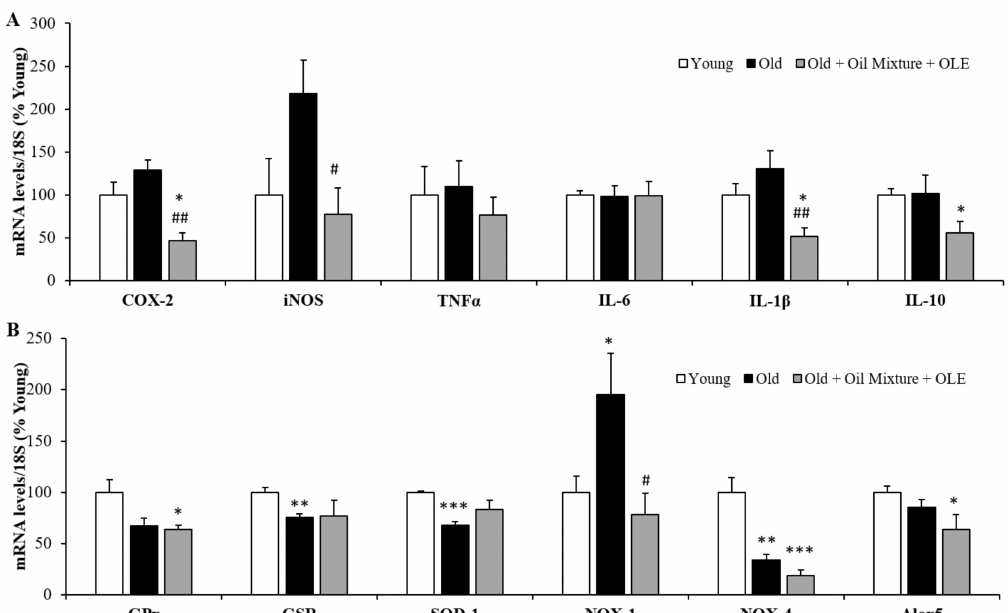
Figure 9. Cardiac mRNA concentrations of cyclooxigenase-2, inducible Nitric Oxide Synthase, Tumor Necrosis Factor α , Interleukin 6, 1 β and 10 ( A ); and of Glutathione Peroxidase and Reductase, Super Oxide Dismutase 1, NADPH oxidases 1 and 4 and Lipoxygenase ( B ) of young rats, old rats and old rats treated 21 days with the Oil Mixture and the OLE. Values are represented as mean ± SEM.* p < 0.05 vs. Young; ** p < 0.01 vs. Young; *** p < 0.001 vs. Young; # p < 0.05 vs. Old; ## p < 0.01 vs.